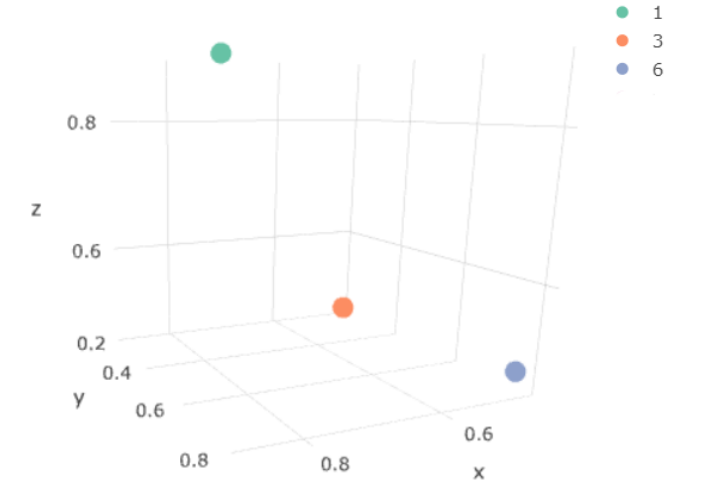
Figure 12. The centroids of the first-layer SOM for the first